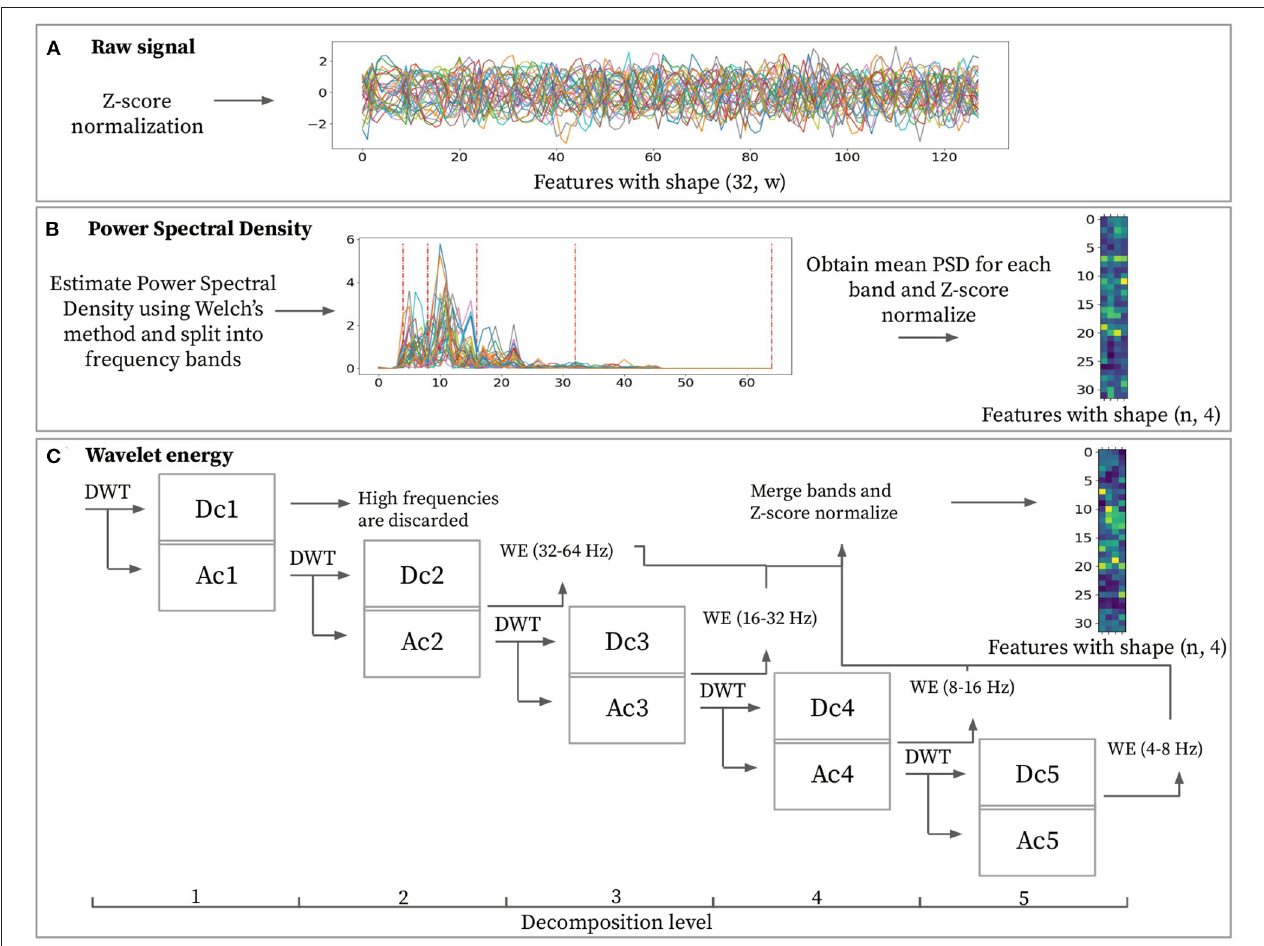
FIGURE 3 | Feature extraction methods for a given sample with window size w = 128. (A) Raw signal features consist of z-score normalized power over time. (B) Power spectral density features are obtained by averaging power spectral density from each frequency band ([4–8, 8–16, 16–32, 32–64 Hz]) then z-score normalizing sample-wise. (C) Discrete wavelet transformation (DWT) is applied to the input signal and then recursively over the approximation coefficients. It is possible to extract the wavelet energy feature vectors using the wavelet energy formula (Equation 1) over detail coefficients [2–5]. The final feature matrix is built based on these wavelet energy feature vectors with z-score normalization applied to